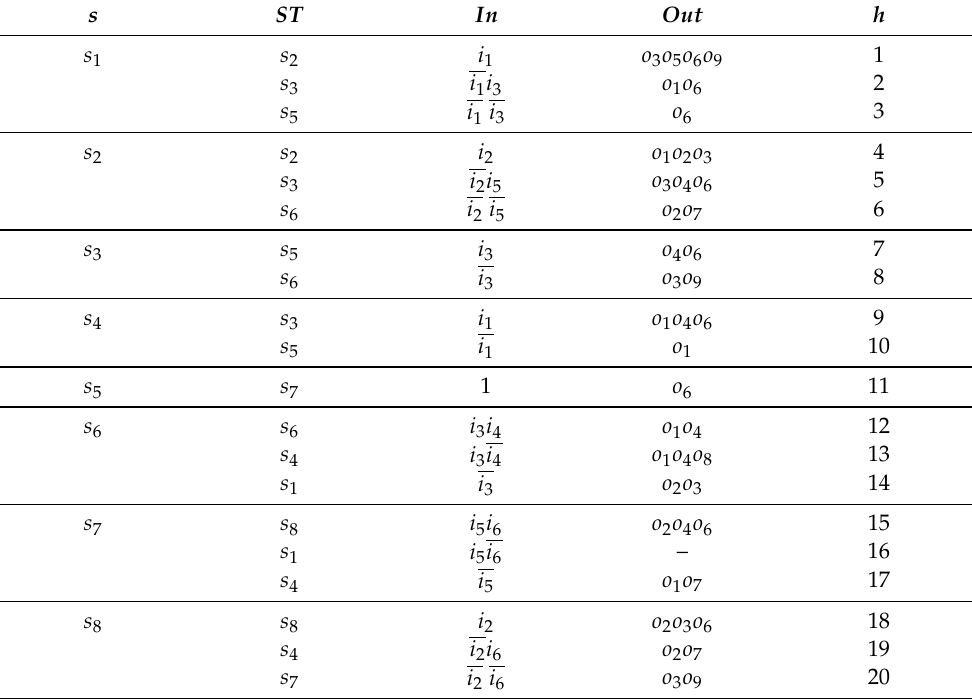
Table 3. State transition table of FSM Ex2.